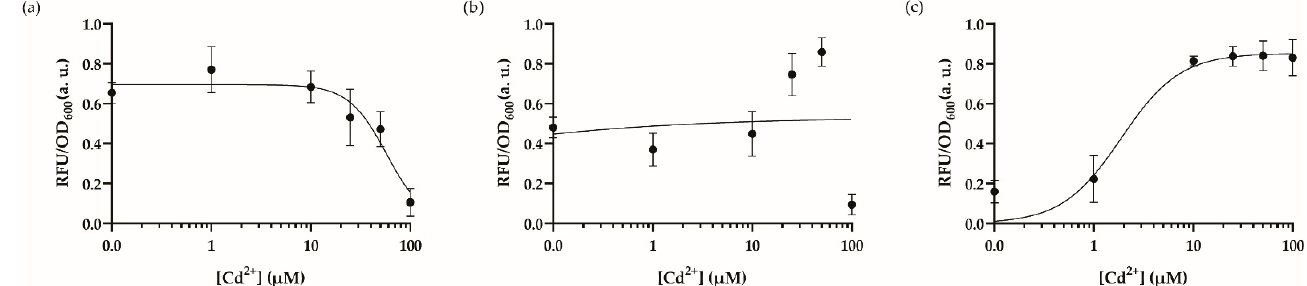
Figure 3. Dynamic range analysis of the engineered cadmium biosensor by changing the cell in- oculum. The dynamic range analysis of the recombinase-based cadmium sensor in MOPS media with cell dilutions ( a ) 1:100, induced in 96-well plates, ( b ) 1:250, induced in 96-well plates, ( c ) 1:50, incubated at 30 ◦ C until OD 600 reaches to 0.4–0.6, then transferred and induced in 96-well plates. All cultures were induced with cadmium ion concentrations from 0–100 µ M and incubated for 20 h at 30 ◦ C in a stable incubator. The fluorescence intensity of each group was compared with each other and 0–1 normalized according to the formula stated in the Materials and Methods section. Data were visualized with mean ± standard error mean (SEM) in each graph. At least three biological replicates were used for each analysis. The point on the y -axis (0.0) represents the uninduced condition/background signal.